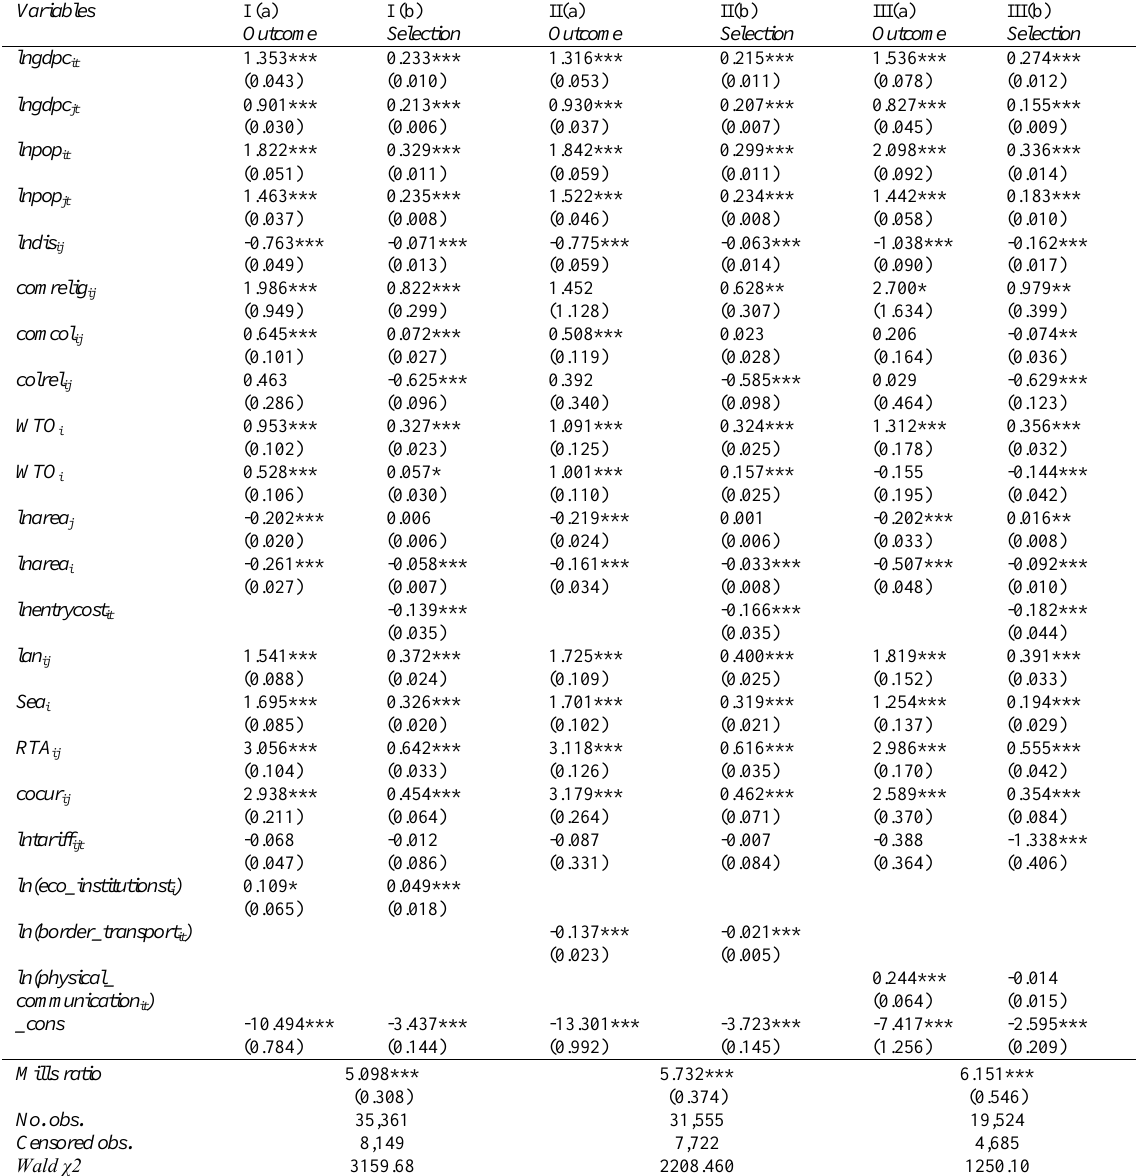
Table 13 : The impacts of border and transport efficiency, quality of economic institutions, physical and communication infrastructure on trade flow of African countries (twostep